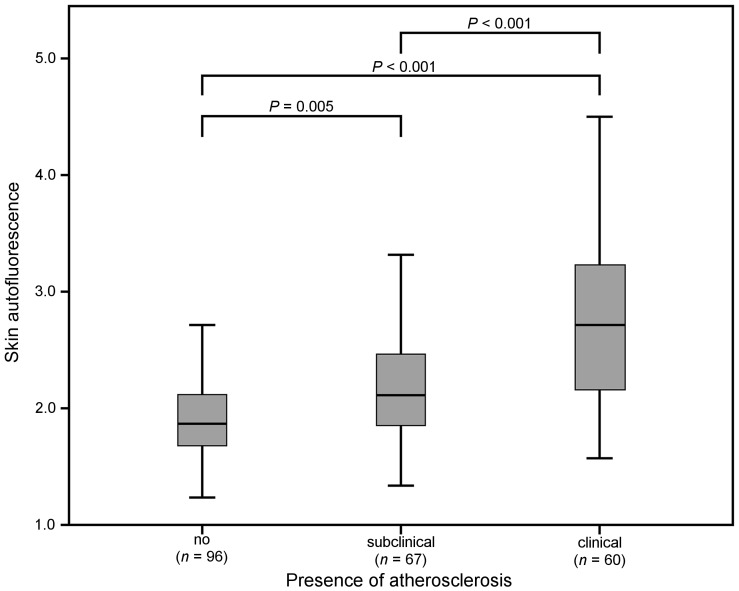
Box plot of skin autofluorescence between patients with increasing degree of atherosclerosis.